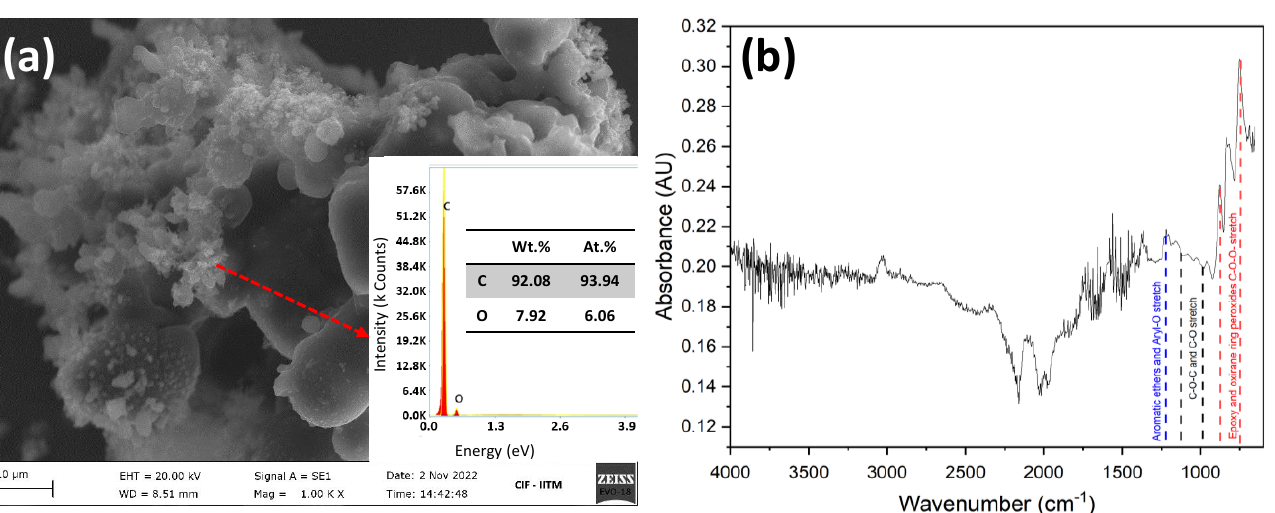
Figure 10. ( a ) SEM image of the carbon particles collected at 0.5 LPM (CO 2 :CH 4 ratio of 25:75 (v%/v%)). The inset shows the EDAX image and the surface composition of carbon and oxygen. ( b ) FTIR spectrum of carbon particles.